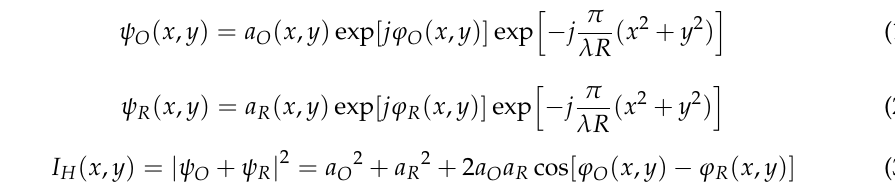
x y O Next, consider a thin and homogeneous phase object (such as a glass plate) stationed on a rotational stage and illuminated with a collimated beam in such a way that the phase of the reference beam is modulated by adjusting the angle of incidence. Figure 2 shows the wavelength of incident light λ . The thickness and refractive index of the phase object are represented by d and n , respectively, and n o denotes the refractive index of air. The angles of incidence and the angle of refraction of the phase object before rotation are θ 1 and θ (cid:48) 1 , respectively, and the angles of incidence and refraction of the phase object are θ 2 and θ (cid:48) 2 , respectively. If the angle of incidence of the incident light is known, it can be changed by rotating the phase object; the amount of phase modulation in the reference wave (Equation (4)) can be further derived from the optical path difference (Equation (5)) before and after the incident angle is